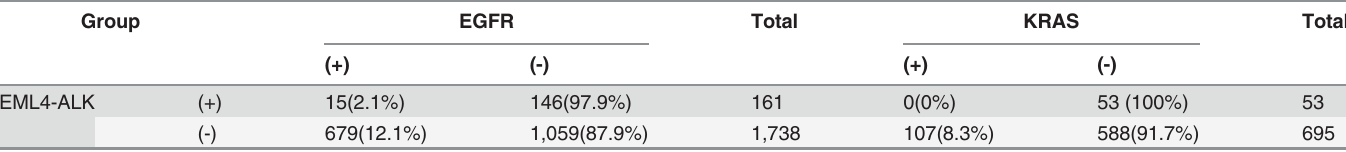
The McNemar test illustrated that there was a statistically signi fi cant difference in the case number between EML4-ALK fusion and EGFR mutation (p = 0.000), the outcome of KRAS followed the same pattern (p =